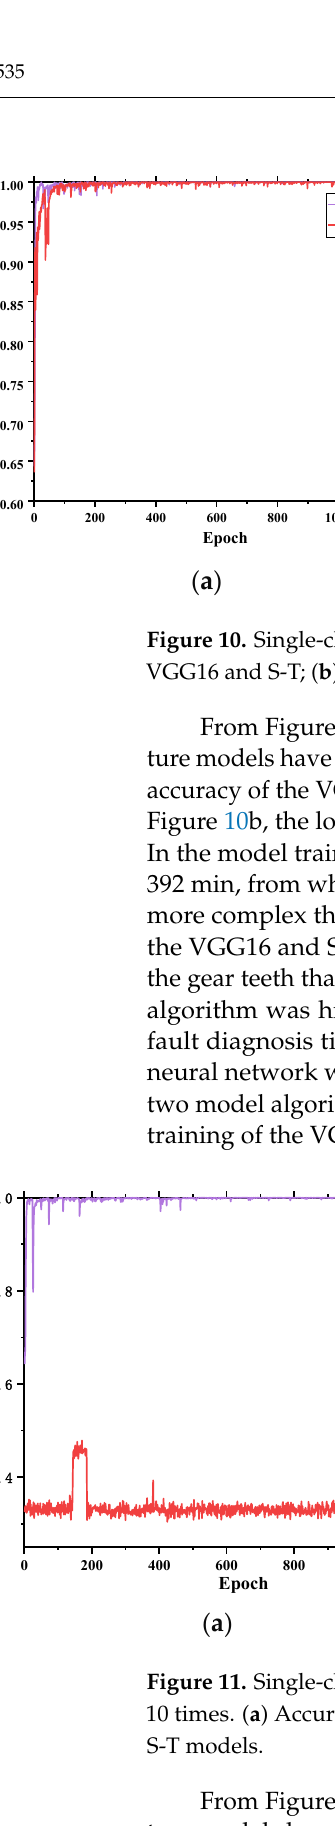
35 Figure 9. SDP images’ arm of one to three pitting of sensor 1 under different l and ζ . The comparison of the method that has been proposed in the paper has been con- ducted with a Swin Transformer (S-T). The S-T model achieves a powerful performance on recognition tasks of image classification, target detection, and semantic segmentation. The S-T model not only has the ability to focus on global modeling, but also adopts the method of moving windows in order to achieve cross-window connection, so that the model can focus on the relevant information of the other adjacent windows and can per- form cross-window feature interaction, which can, to a certain extent, expand the percep- tual field and can improve the computational efficiency. Therefore, two deep learning models have been chosen for comparison in this study, the VGG16 and the S-T, and the parameter settings of these two models are shown in Table 2. The training metrics of the two models are shown in Figure 10. The hardware configurations of the two models run in an environment with a provided NVIDIA GeForce RTX 3080 GPU with 10 GB, Intel processor running at 2.9 GHz with i7-10700. Table 2. Training parameters of each model.